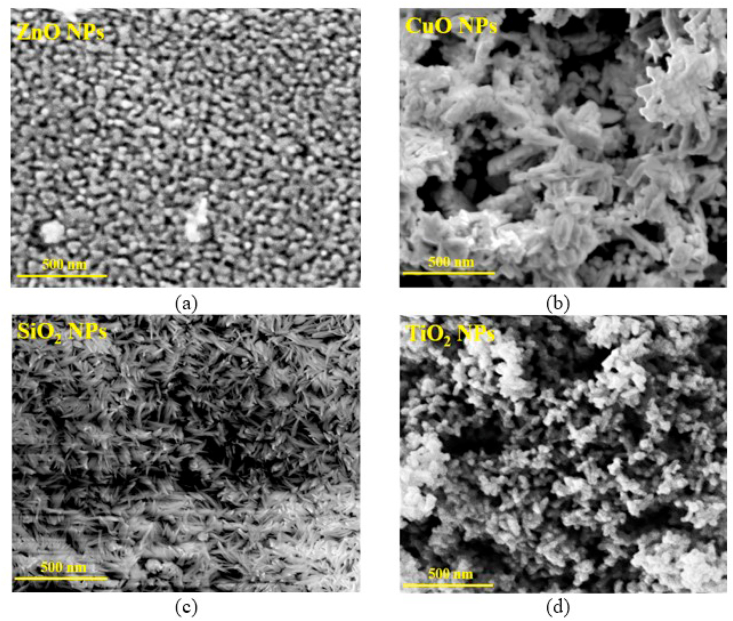
The SEM images of (a) ZnO NPs, (b) CuO NPs, (c) SiO2 NPs and (d) TiO2 NPs.